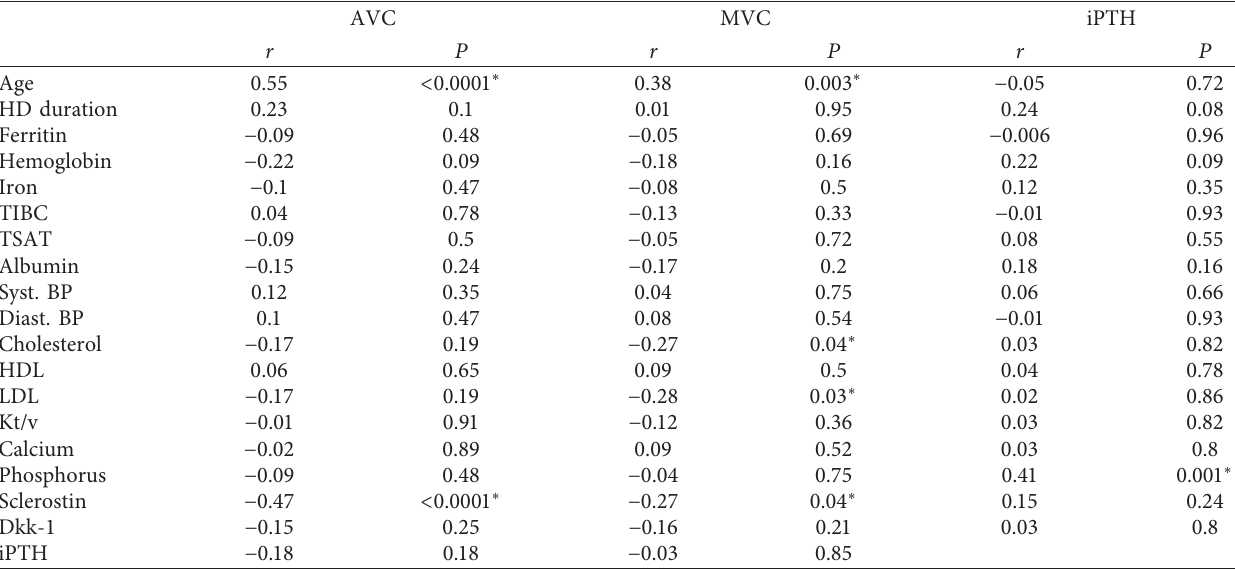
Table 7: Correlation between AVC, MVC, iPTH, and some clinical and chemical